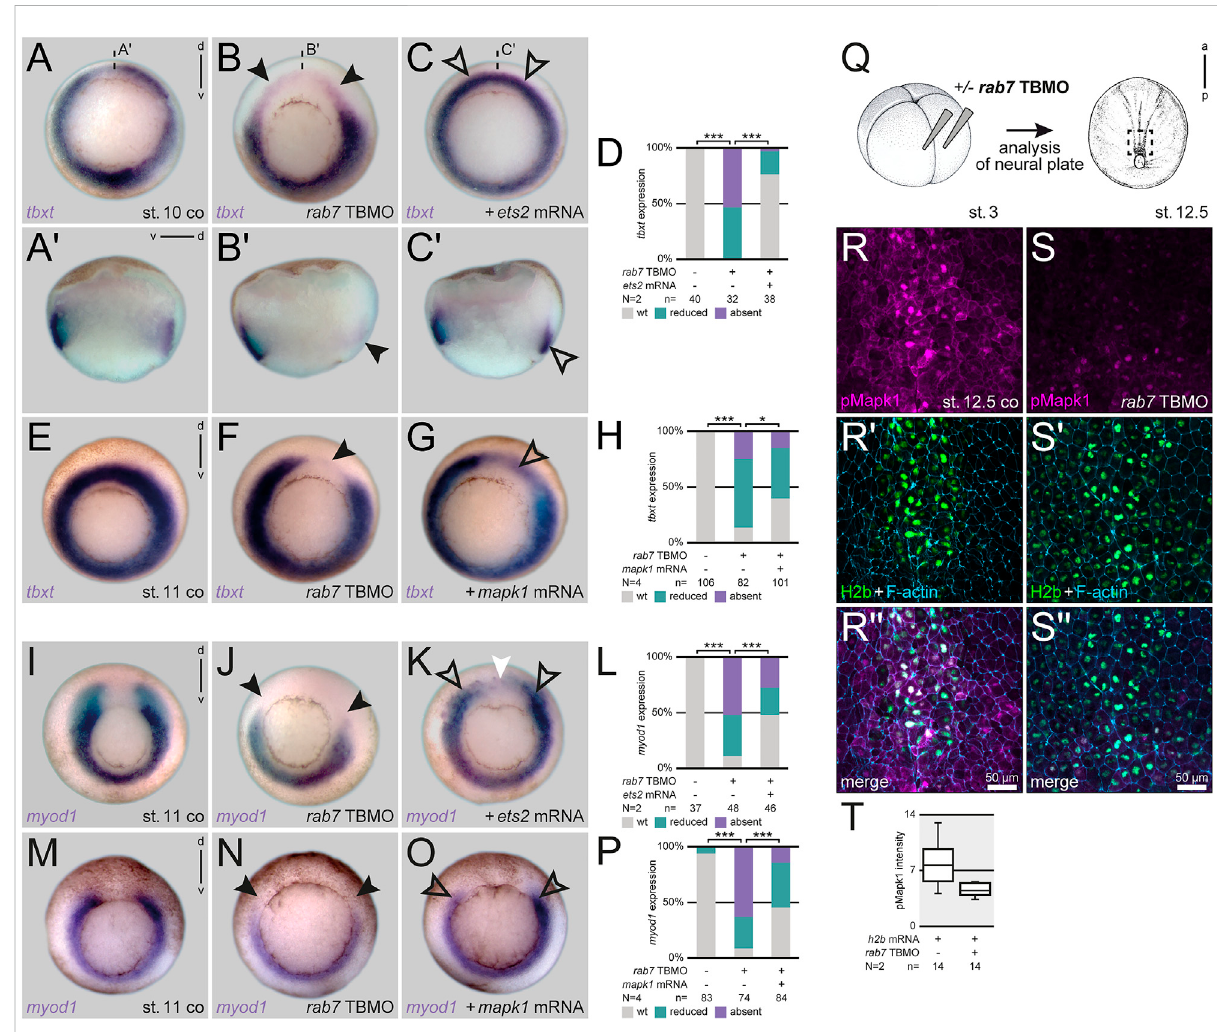
FIGURE 3 Loss of Rab7 blocks dorsal mesoderm speci fi cation upstream of Mapk activation. (A) Uniform circular appearance of tbxt expression of st. 10 Xenopus embryos (B) faded due to dorsal knockdown of rab7 (black arrowheads). (C) Rescue injection of ets2 mRNA restored expression almost back to wild type level (outlined black arrowheads). (A 9 – C 9 ) Panels beneath depict corresponding sagittal sections. (D) Quanti fi cation of tbxt expressionrescuedby ets2 mRNA. (E) Circular tbxt expressionofst.11specimen (F) fadeduponunilateraldorsal rab7 LOF(blackarrowhead).